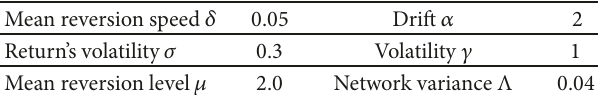
Table 1: Model parameter